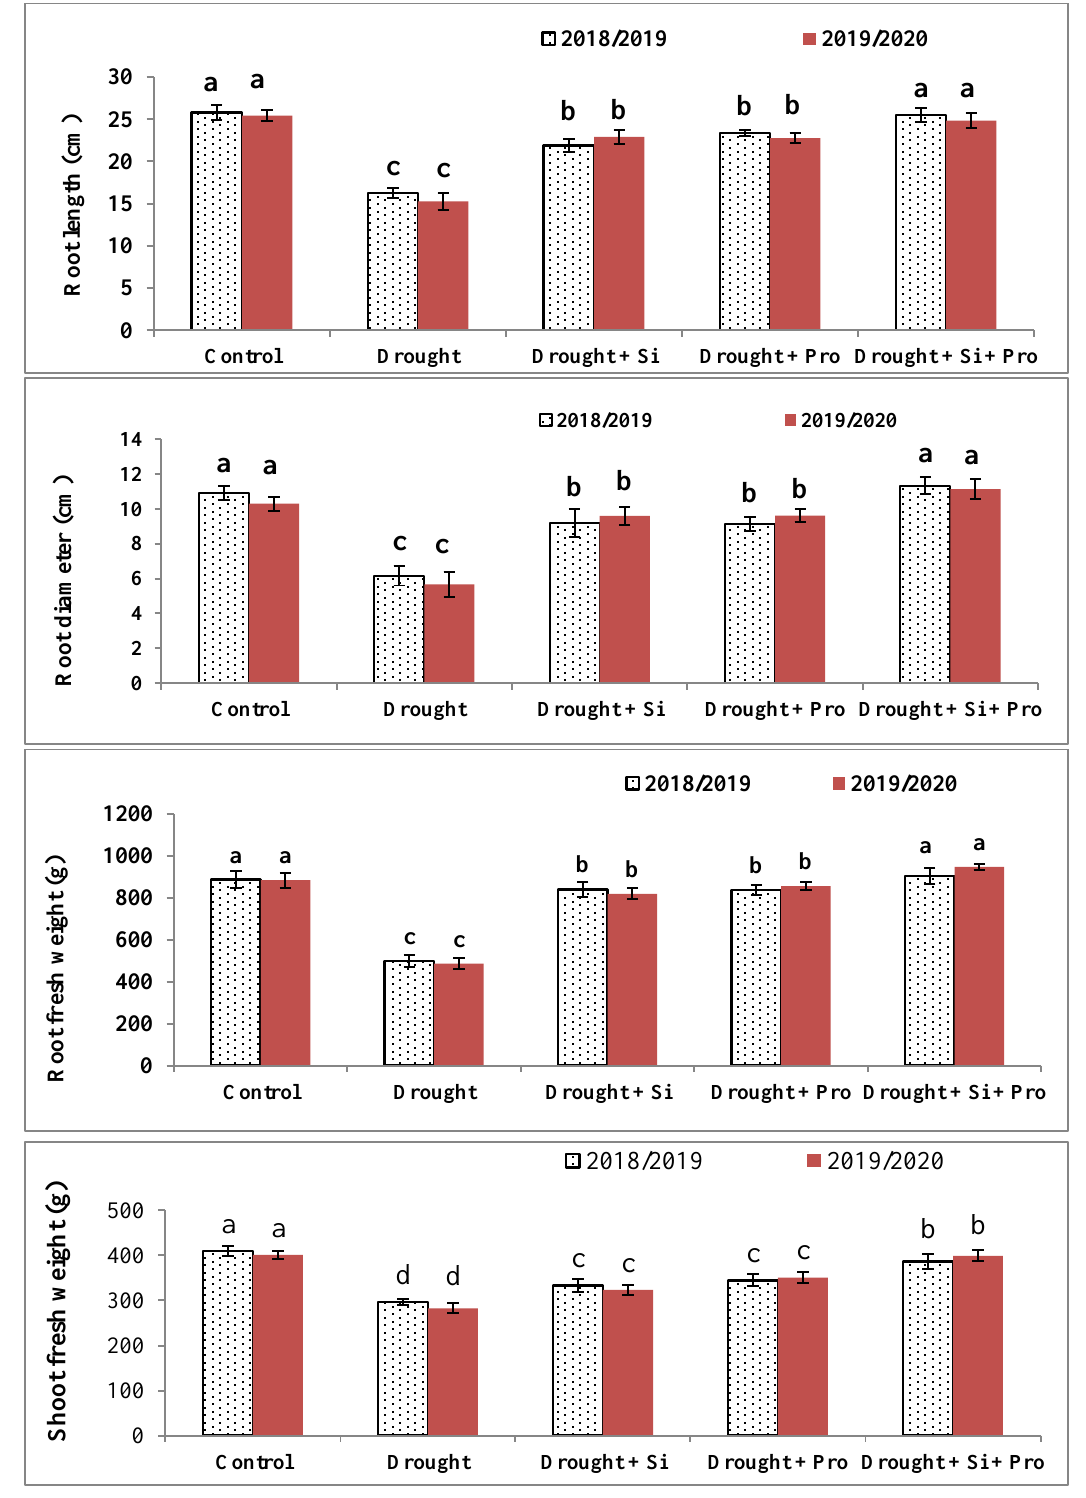
Figure 1. Effect of silicon and proline on root length ( A ), root diameter ( B ), root fresh weight ( C ) and shoot fresh weight ( D ) of sugar beet plants under drought in the 2018/2019 and 2019/2020 seasons. Bars followed by different letters are significantly different according to Duncan’s multiple range tests (DMRTs) at p < 0.05. Si: Silicon, Pro: